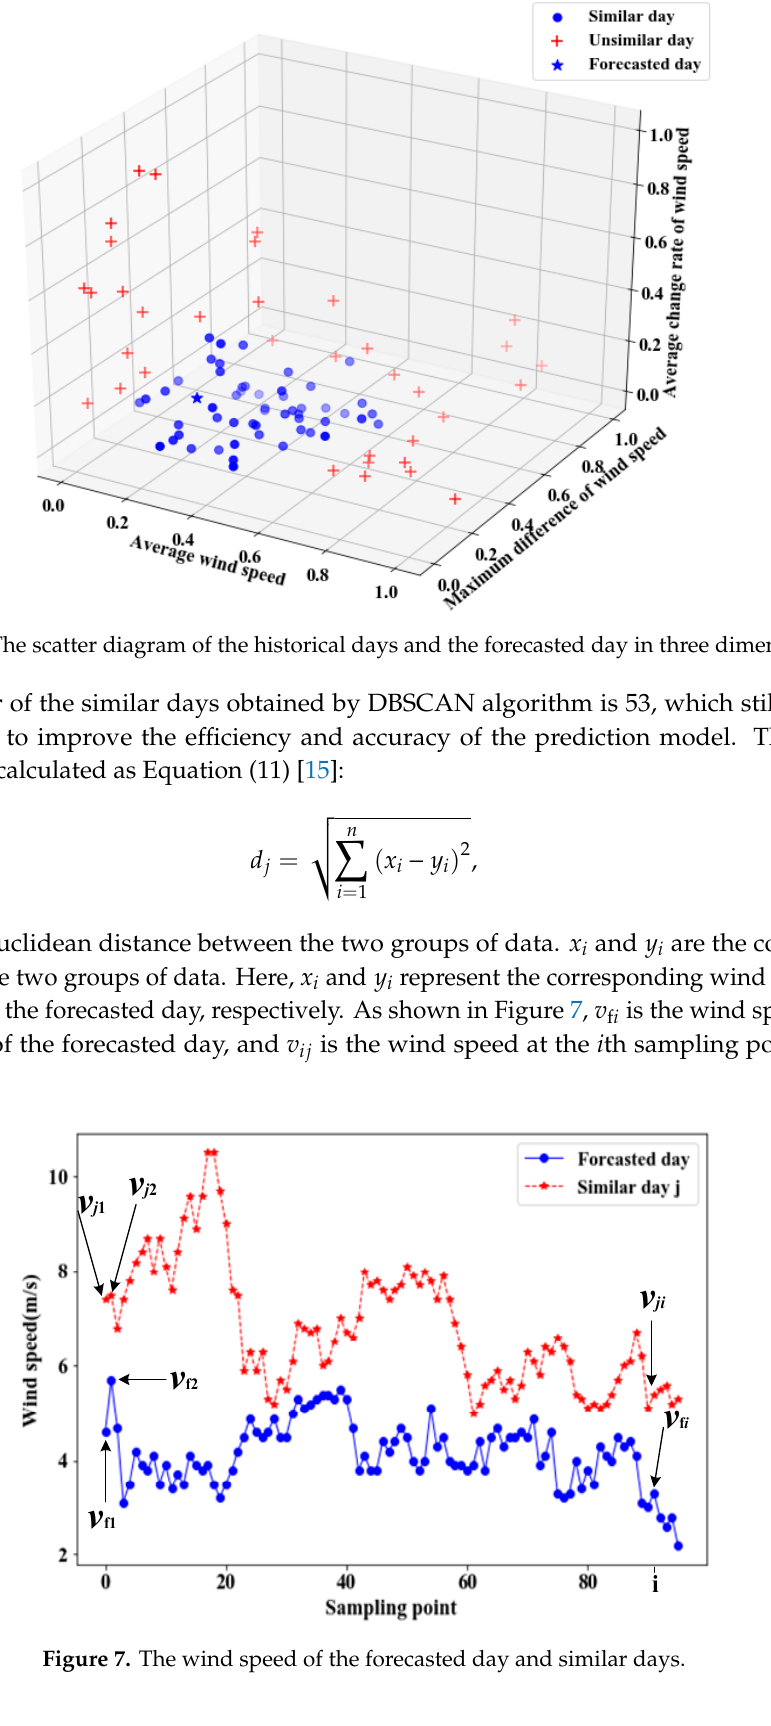
8 of 15 Figure 5. The scatter diagram of the historical days and the forecasted day in three dimensions. Secondly, the parameters eps and Minpts of DBSCAN are iterated in equal steps. In this paper, parameters that can divide all sample points evenly into two clusters are used, and historical